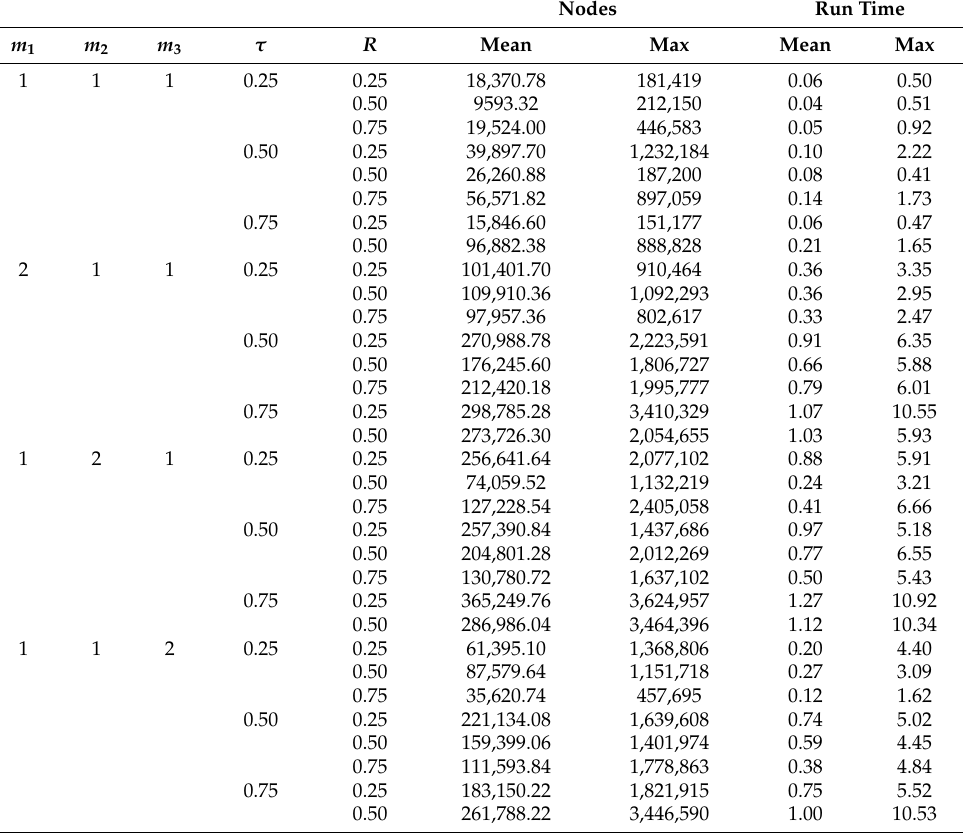
Table 4. The effects of different developers on the performance of BB for n =